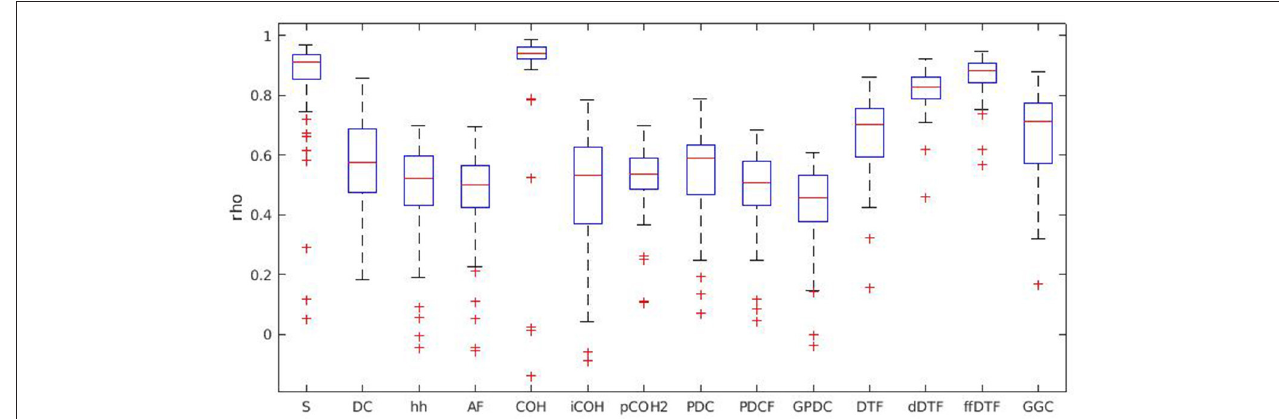
FIGURE 2 | Boxplots for all measures of interaction. Boxplots show the distribution of Spearman’s rho in the whole sample, individually for each measure. S, spectrum; DC, direct causality; h, transfer function; Af, transfer function polynomial; COH, real valued coherence; iCOH, complex coherence; pCOH, partial coherence; PDC, partial directed coherence; PDCF, partial directed coherence factor; GPDC, generalized partial directed coherence; DTF, directed transfer function; dDTF, direct directed transfer function; ffDTF, full frequency directed transfer function; GGC, Geweke’s Granger causality.